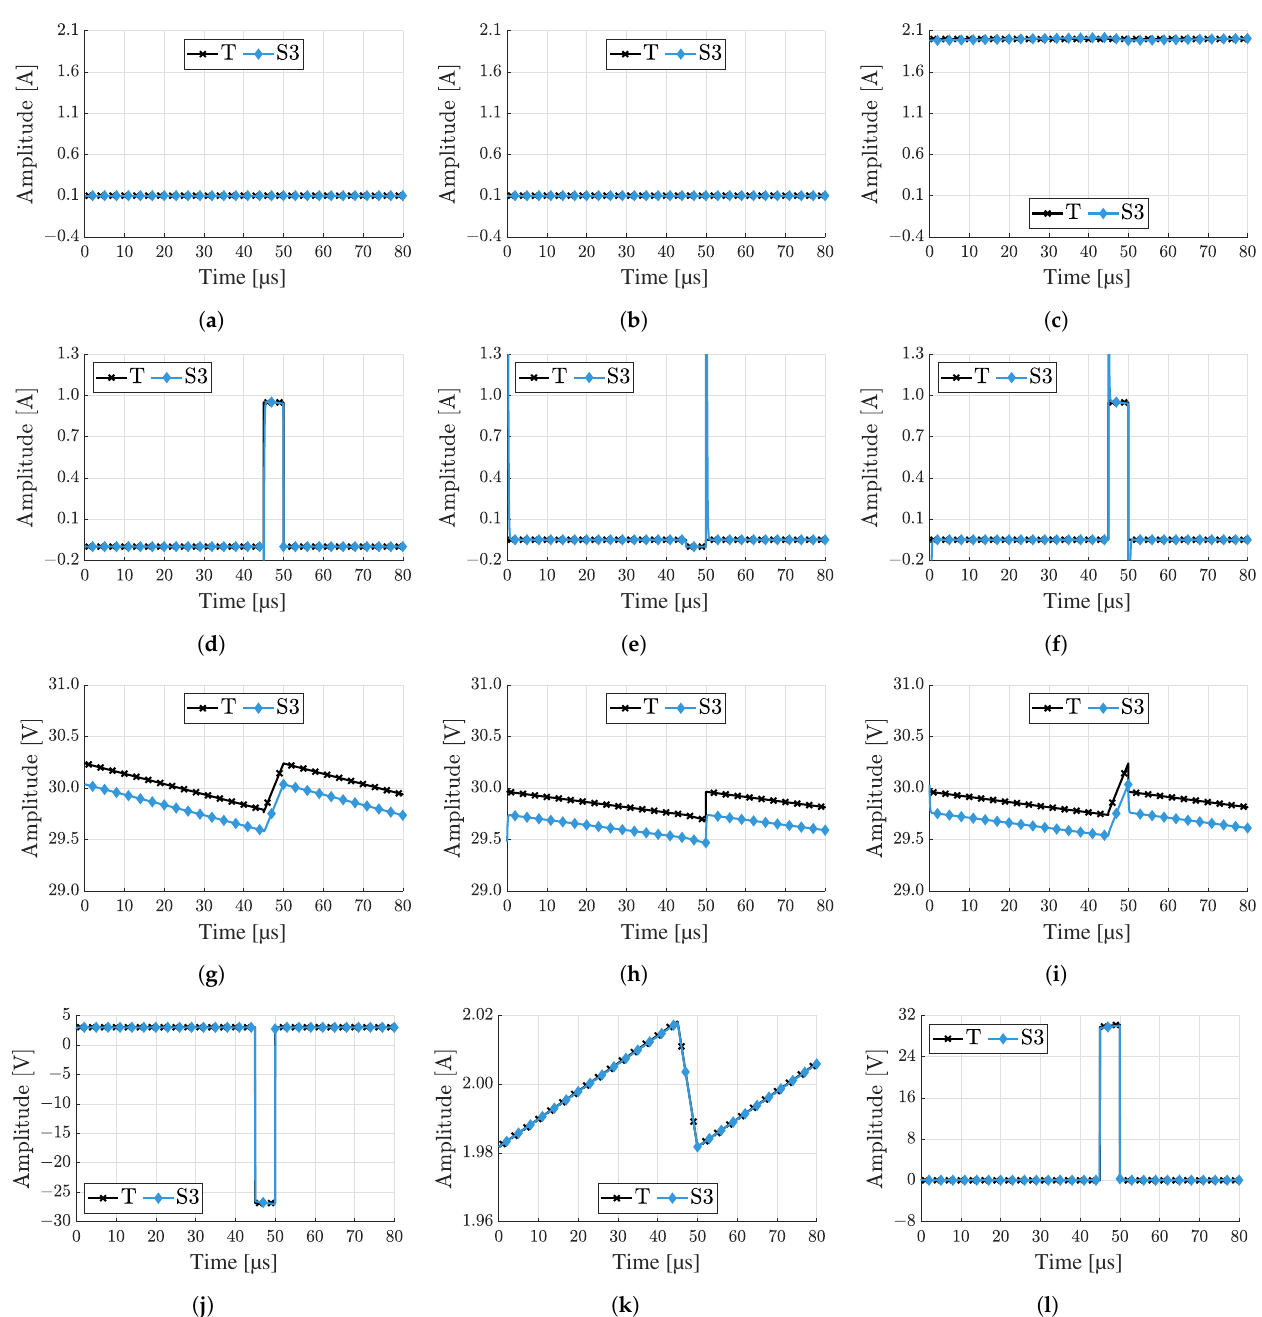
( t ) with small ripple B ( t ) ; ( k ) i ( t ) without small ripple L B B